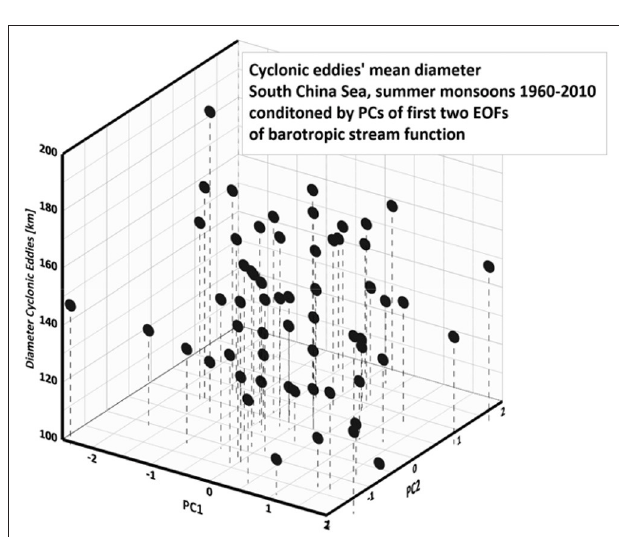
FIGURE 4 | Seasonsal means of cyclonic eddies’ diameter in the South China, 1960–2010, given as function of the principal components of the first two EOFs of the barotropic stream function in the South China Sea as shown in Figure 3